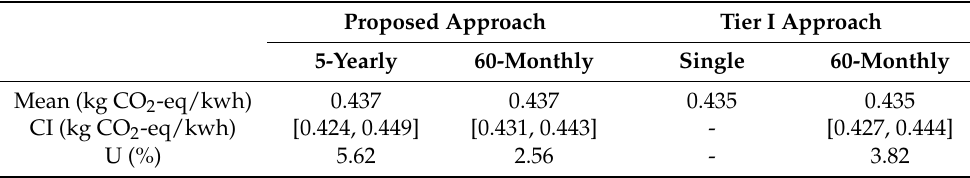
Table 5. The mean, CI, and U of the electricity emission factors for different